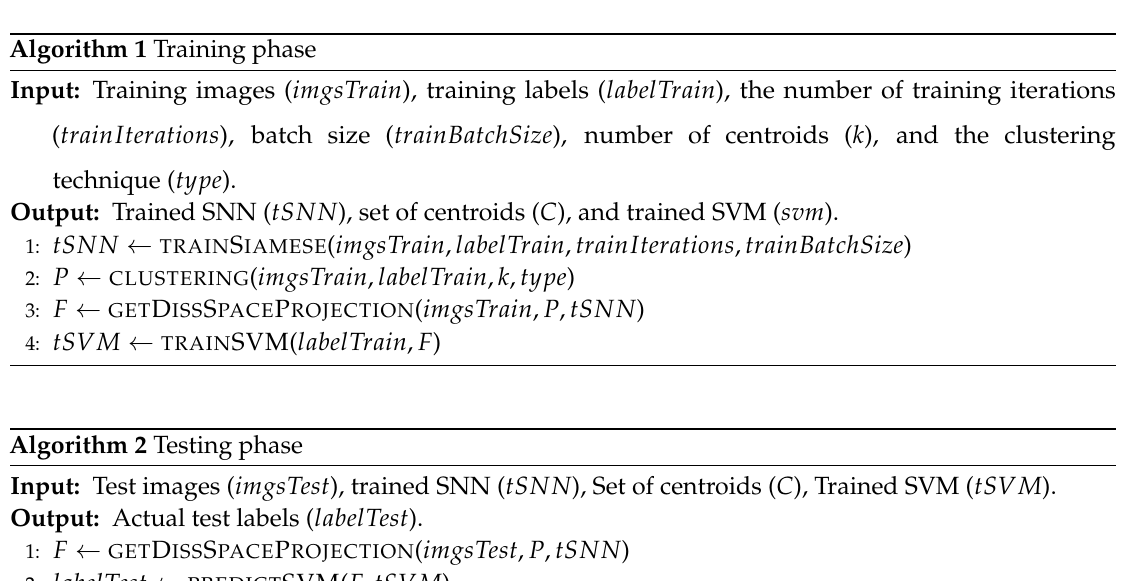
Algorithm 1 Training phase